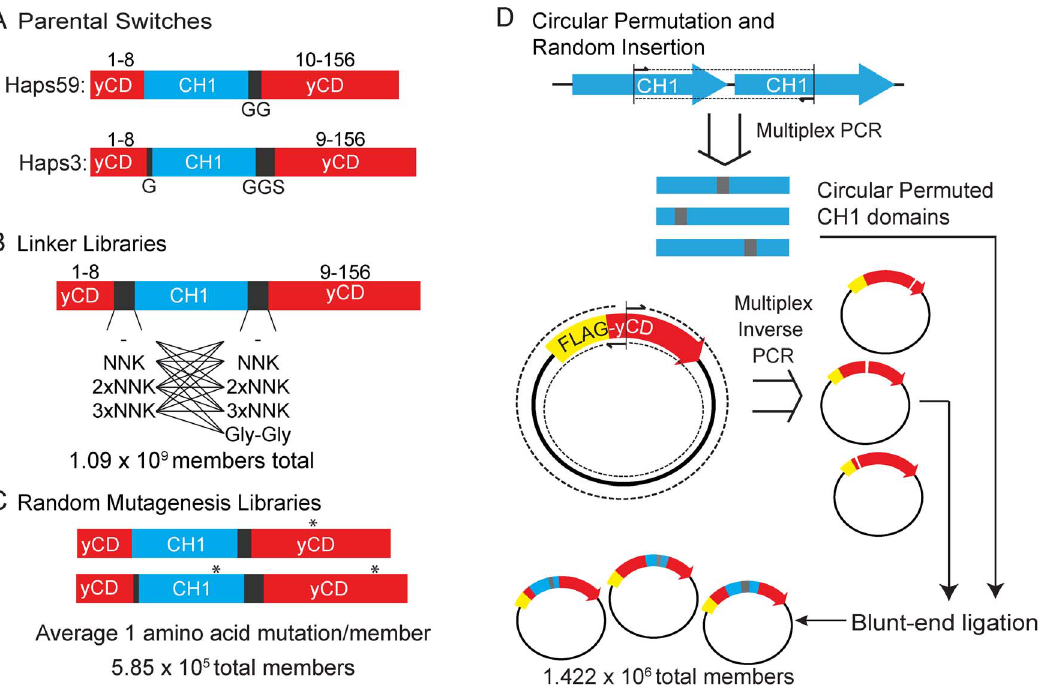
Figure 2. Strategies for creating improved HIF-1 a -activate protein switches. (A) Sequences of parental switches Haps3 and Haps59. Numbers above indicate the amino acid residues in yCD. Letters below indicate the 1-letter abbreviation amino acid sequence of the corresponding linker. (B) Schematic of the linker libraries created in Haps59. Lines indicate which combinations of N- and C-terminal linkers were combined to comprise the 18 libraries. (C) Schematic of random mutagenesis libraries of Haps59 and Haps3. A * indicates a representative point mutation. (D) Schematic of the construction of libraries of random circular permutations of CH1 that are randomly inserted into the yCD domain of FLAG-tagged yCD. Multiplex PCR was used to create all possible circular permutations of the CH1 domain. Multiplex inverse PCR was used to create all possible insertion sites within yCD. These two populations of DNA were ligated to create the